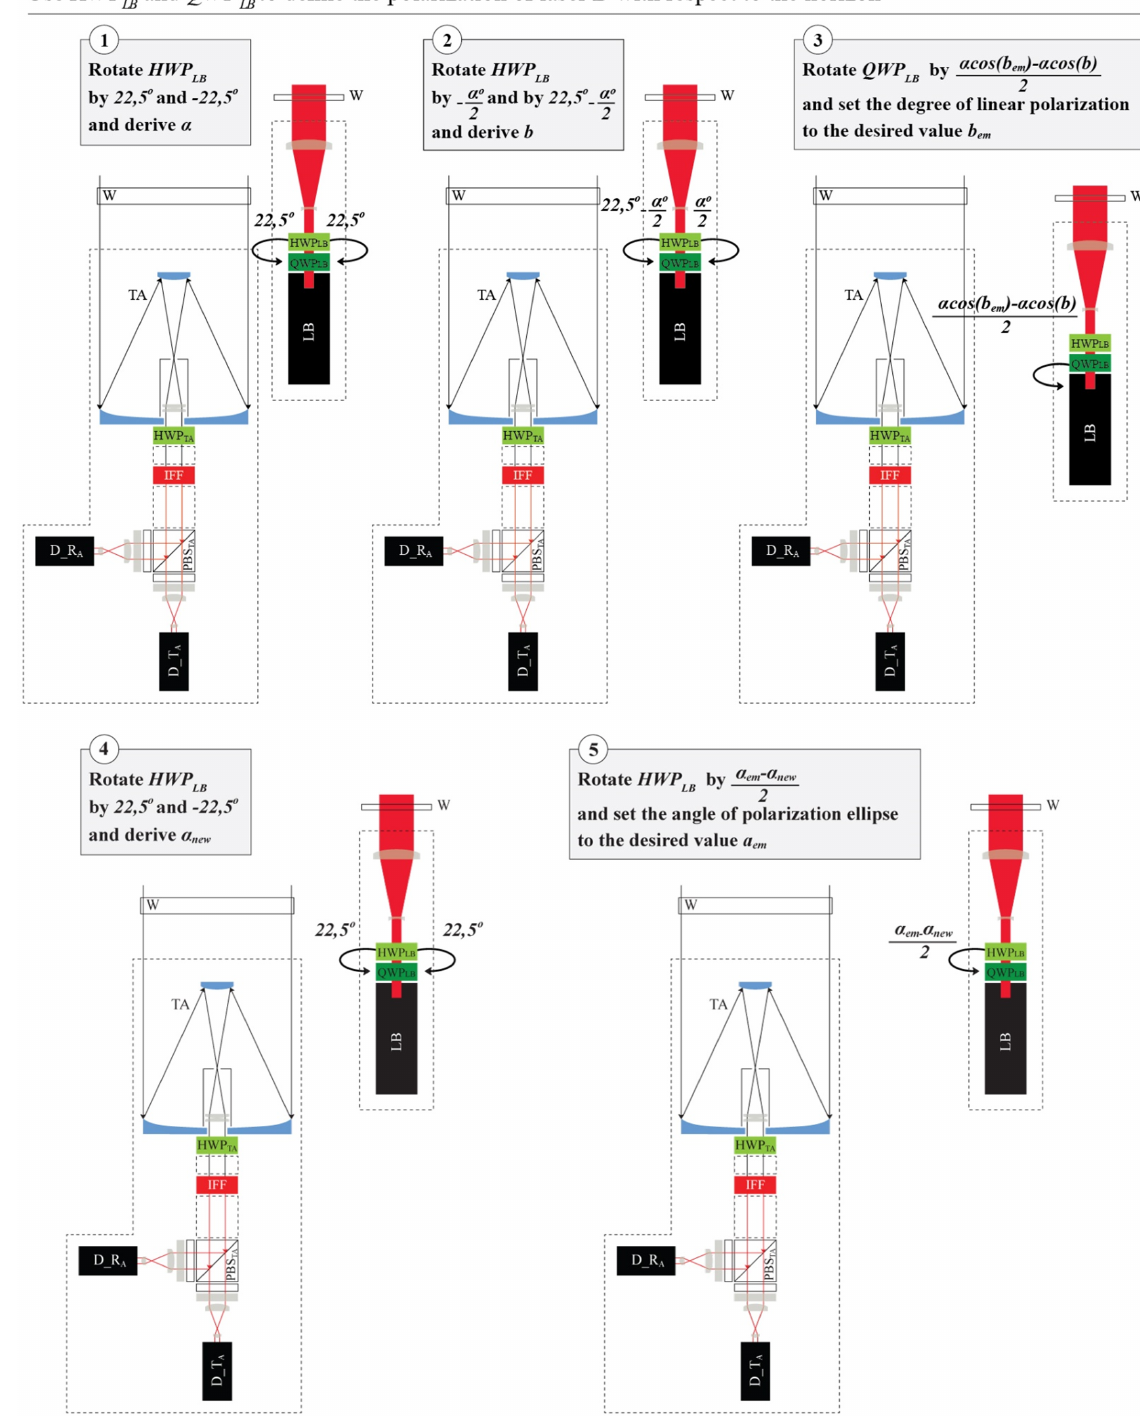
Figure 12. Methodology for defining the polarization of the emitted light from laser B with respect to the horizon.